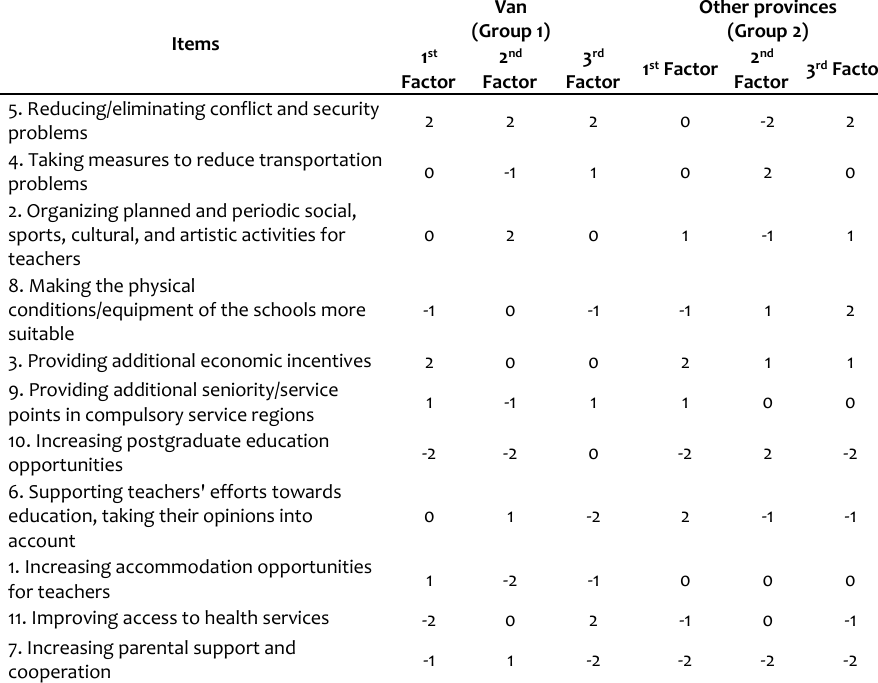
Table 4. Q Values Regarding Solutions Towards Teacher Turnover